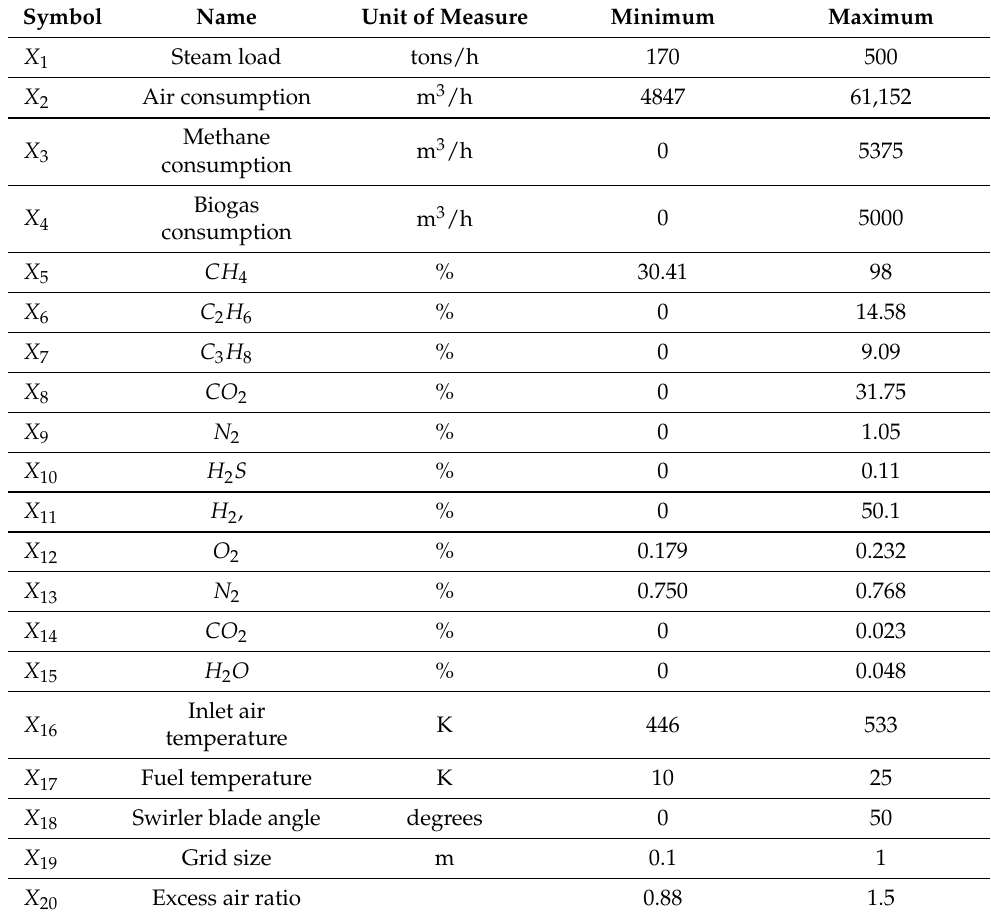
Table 1. Indicators affecting the efficiency of the